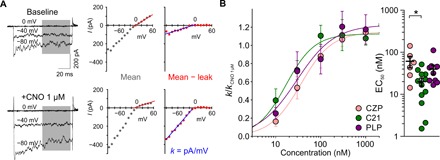
Electrophysiology-based screen of hM4D(Gi) activation.(A) Left: Representative traces of Kir3.1 and Kir3.2 currents with (+CNO 1 μM, bottom) and without (baseline, top) hM4D(Gi) agonist application. Middle: Mean current measured during the time indicated by the gray area in the left panel, plotted against holding voltage. The red line indicates the calculation of the membrane leak conductance, obtained from a linear fit between 0 and +50 mV. Right: Leak-subtracted Kir3.1/Kir3.2-mediated currents, together with a linear fit to currents at negative potentials (blue). The slope of the current-voltage relationship (k) was used for subsequent analysis of hM4D(Gi) activation. (B) Left: CZP, C21, and PLP act as potent agonists of hM4D(Gi). All data are shown normalized to CNO (1 μM) as a positive control and fitted by a Hill equation. Right: EC50 of CZP, C21, and PLP (CZP: EC50 = 61 ± 19 nM, n = 6; PLP: EC50 = 40 ± 10 nM, n = 9; C21: EC50 = 20 ± 4 nM; *P < 0.05, one-way ANOVA with Bonferroni post hoc test).